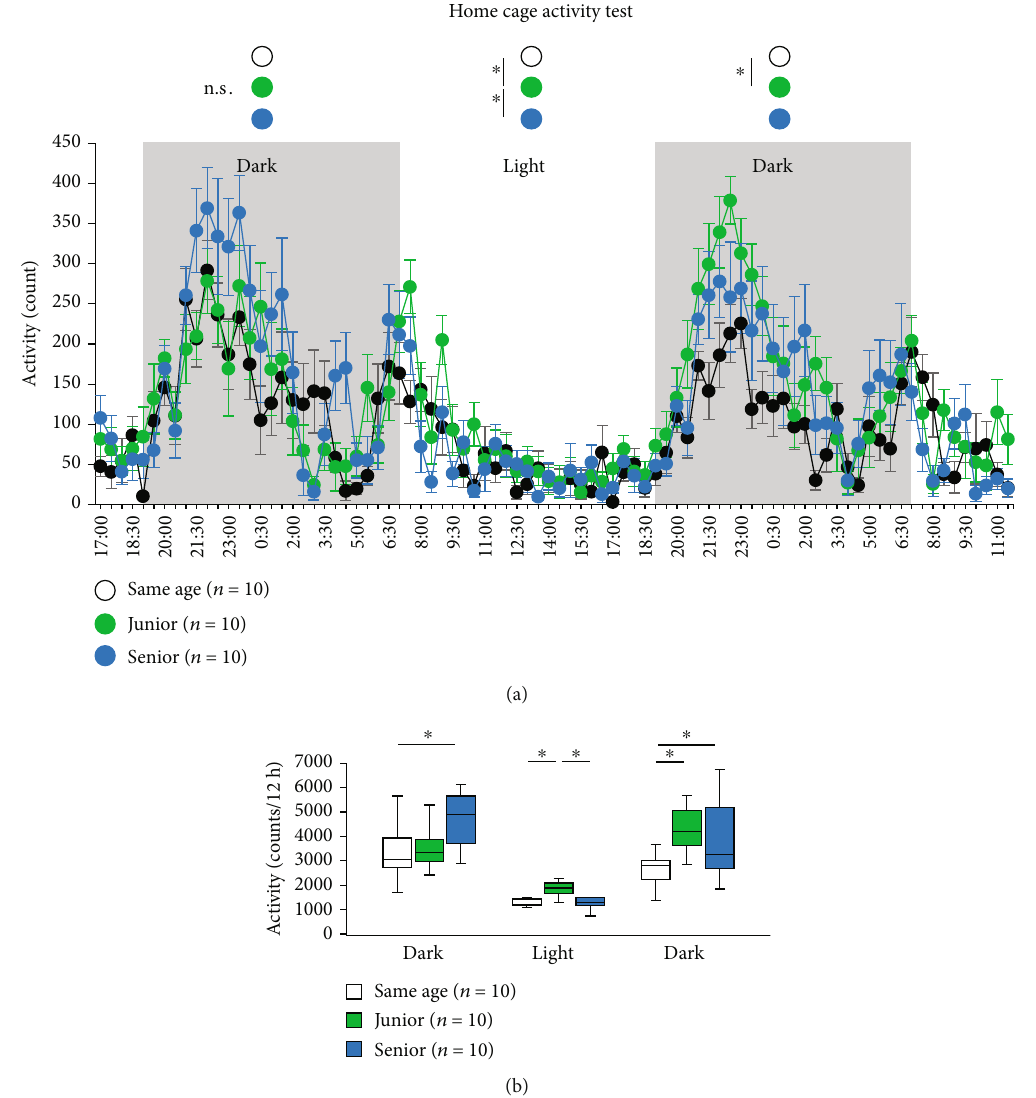
Figure 5: E ff ect of group housing condition on performance on the home-cage activity test. Graphs showing the spontaneous locomotor activity in each 30min period (a) and total locomotor activity in the fi rst dark phase, fi rst light phase, and second dark phase (b). Data are presented as the mean ± SEM in (a) and box plots in (b). ∗ Signi fi cant di ff erence in comparisons between groups ( p < 0 : 05 ). The p values were calculated using two-way repeated measures ANOVA in (a) and two-way ANOVA in